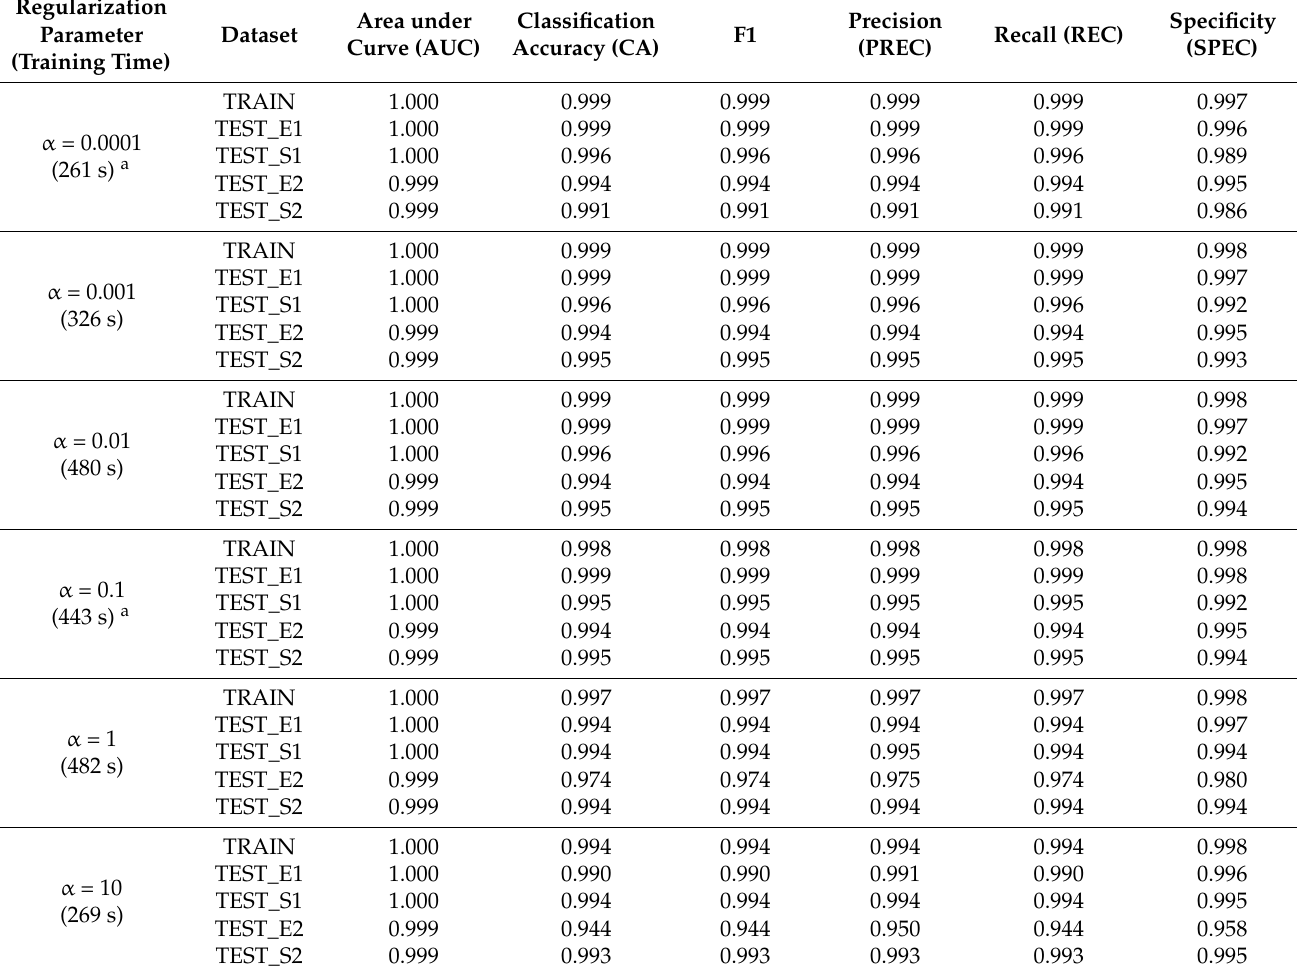
Table A1. Classification performance metrics of the training and testing